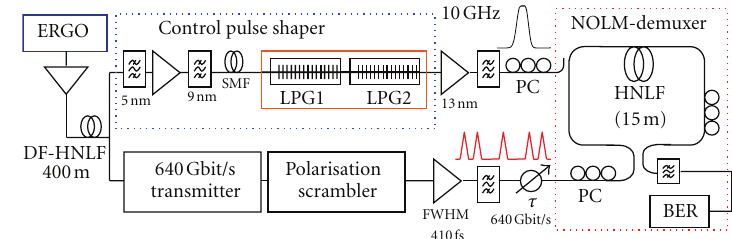
Figure 18: Setup for PI-NOLM